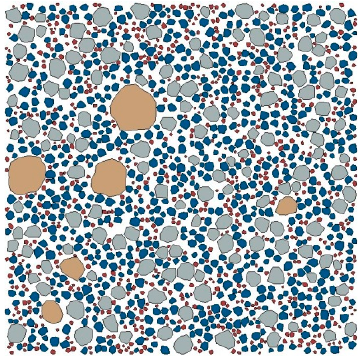
Figure 3. 2D RPA structure of